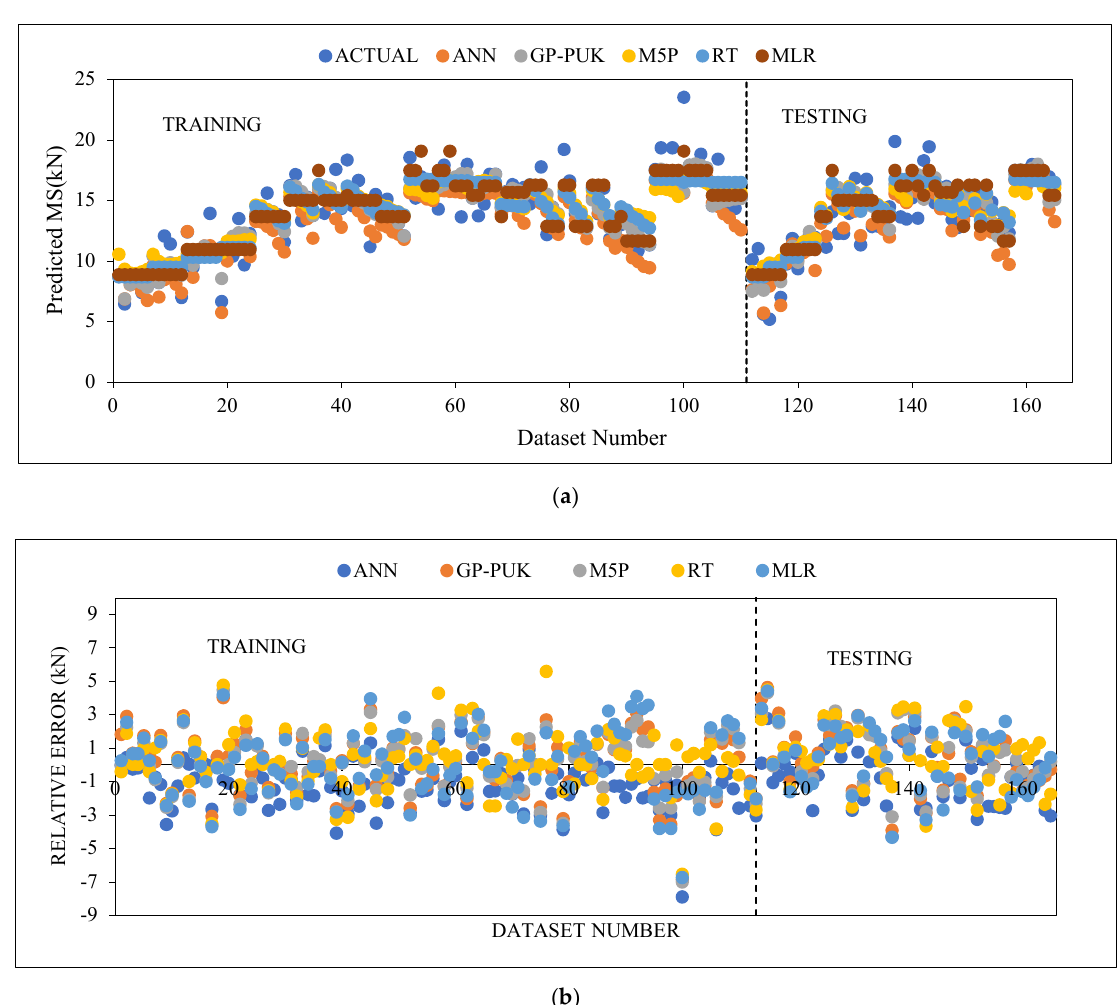
Figure 11. Boxplot with all applied models using the testing stage.